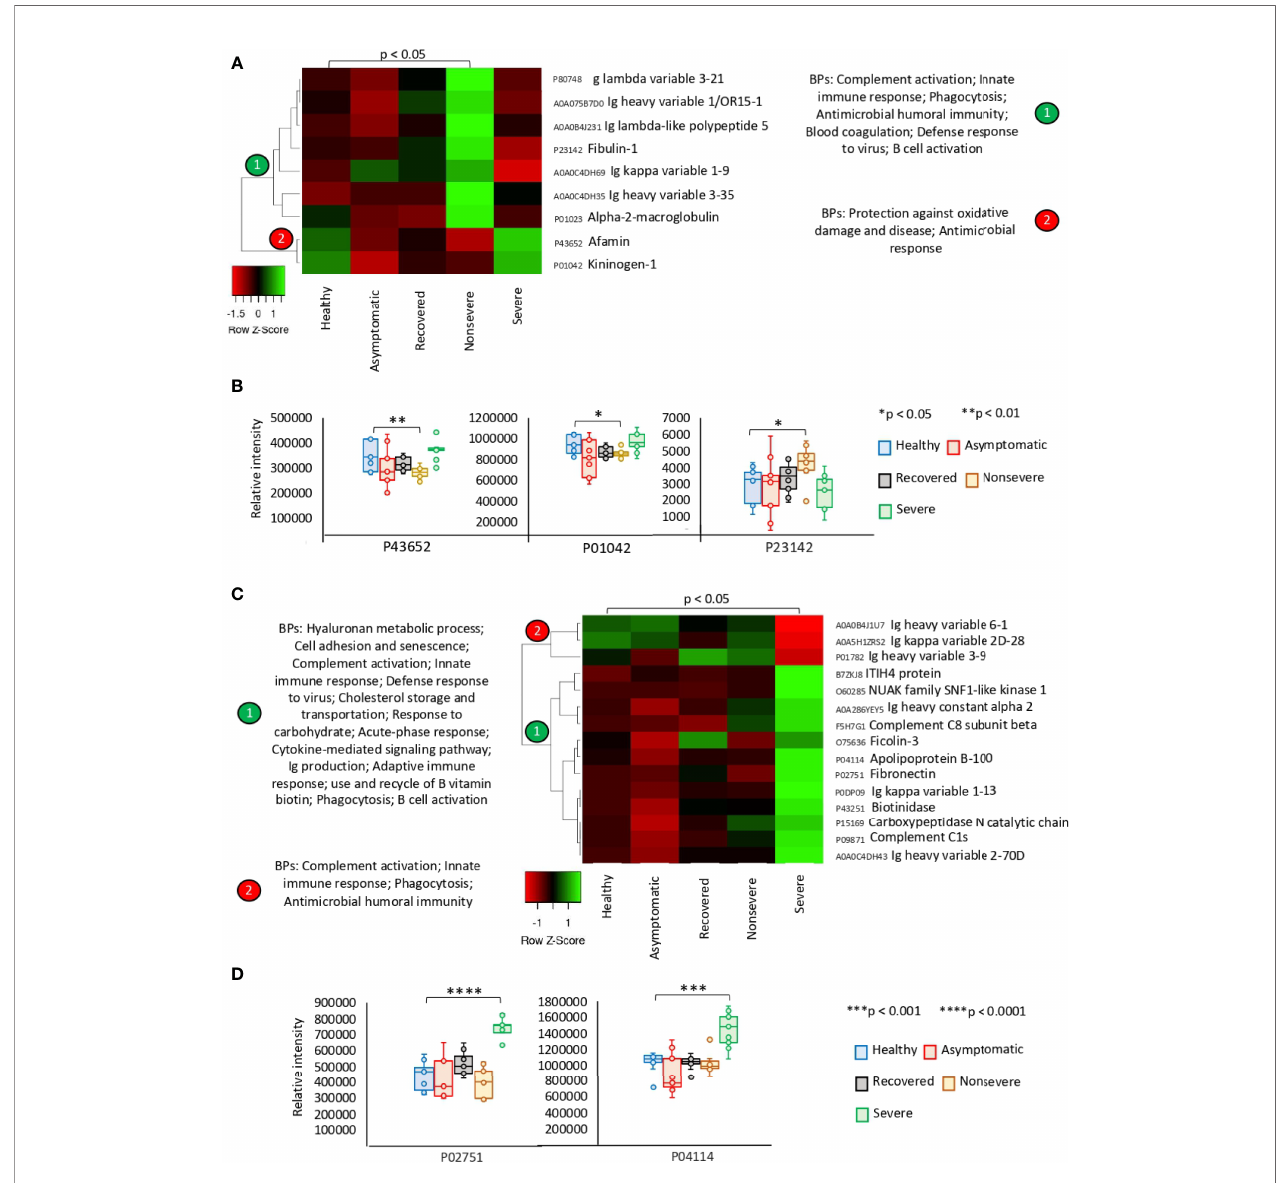
FIGURE 3 | Exclusive differential representation of proteins in sera from COVID-19 nonsevere and severe cases. (A) Heatmap of proteins signi fi cantly dysregulated ( Z -scored original value) in nonsevere cases only ( p < 0.05; unpaired two-sided Welch ’ s t -test). Biological processes (BPs) are shown for each cluster of proteins differentially represented in response to COVID-19 (cluster 1, overrepresented; cluster 2, underrepresented). (B) Change in levels of three selected proteins with signi fi cant differences between nonsevere cases and healthy controls (* p < 0.05, ** p < 0.01; unpaired two-sided Welch ’ s t -test). (C) Heatmap of proteins signi fi cantly dysregulated ( Z -scored original value) in severe cases only ( p < 0.05; unpaired two-sided Welch ’ s t -test). Biological processes (BPs) are shown for each cluster of proteins differentially represented in response to COVID-19 (cluster 1, overrepresented; cluster 2, underrepresented). (D) Change in levels of two selected proteins with signi fi cant differences between severe cases and healthy controls (*** p < 0.001, **** p < 0.0001; unpaired two-sided Welch ’ s t